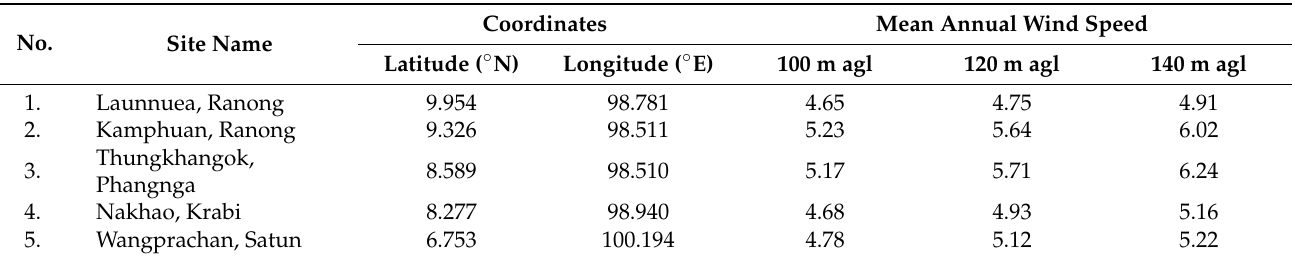
Table 4. The geographical coordinates of the potential sites for wind power plants and their mean annual wind speeds at elevations of 100 m, 120 m and 140 m